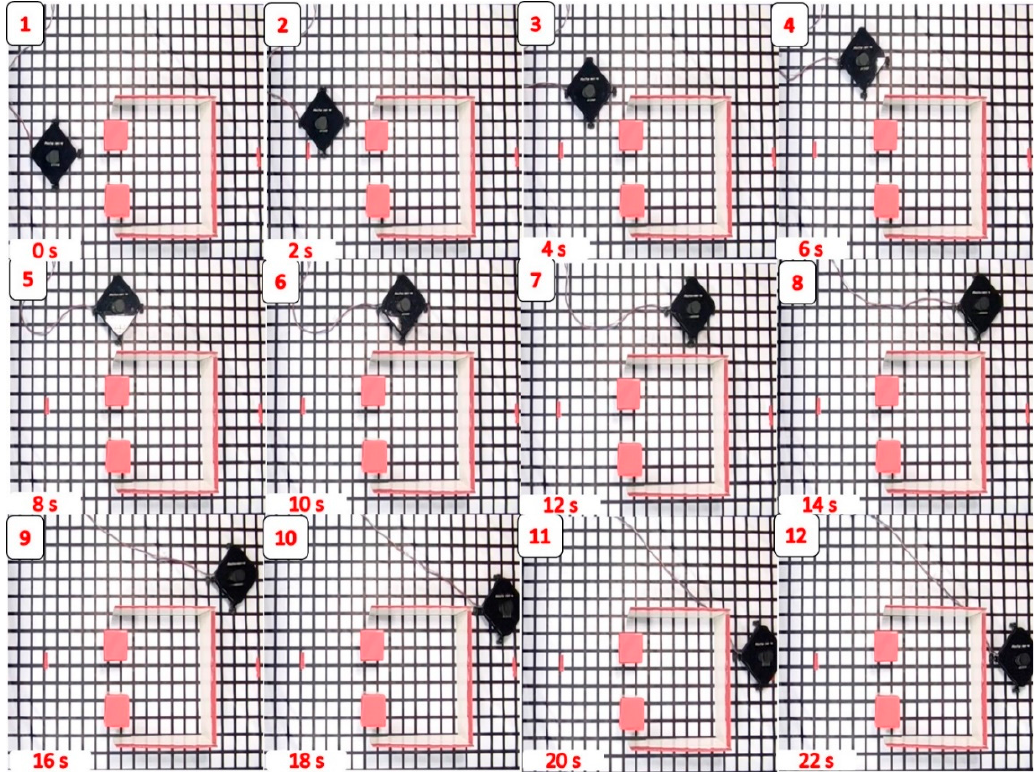
Figure 17. The experimental path that is generated by using Hybrid A* in Map3. The blue line is the planned path, while the red line is the actual path.